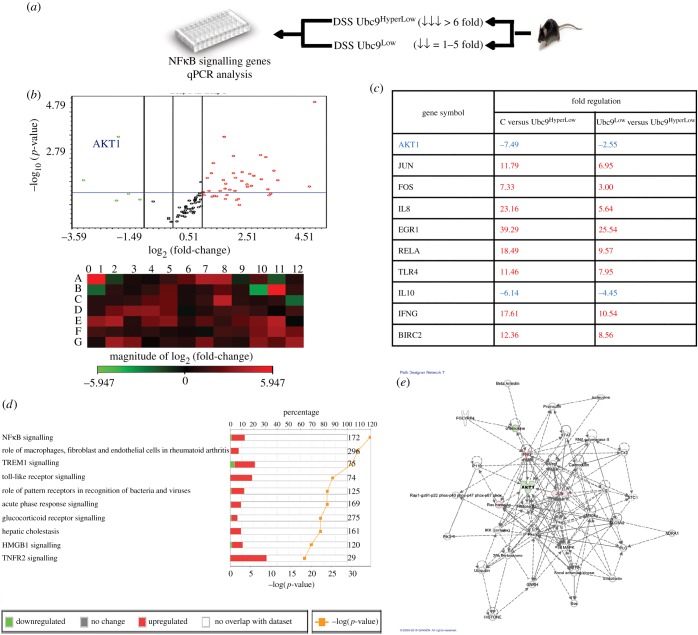
Ubc9 levels correlate with the severity of inflammation in DSS-7 mice. (a) Schematic overview of steps involved in gene expression analysis using qPCR in mice. Total RNA was extracted by colonic tissue of DSS-treated animals with hyperlow Ubc9 and low Ubc9 along with the control group. This RNA was processed for qPCR array and the data plotted as volcano plots (b, top) display significant inflammatory gene activation in DSS animals. In volcano pots, horizontal axis shows fold change (log2) and vertical axis represents the statistically significant dysregulated genes (−log10 scale; p < 0.05, blue line). Heat maps (b, bottom) show pattern of expression of DSS-7-Ubc9HyperLow compared with DSS-7-Ubc9Low. (c) Table showing the fold change of various significant genes altered in DSS-7 mice samples. (d) IPA comparative analysis showing significant signalling altered in DSS-7-Ubc9HyperLow compared with DSS-7-Ubc9Low. (e) Akt1-dependent IPA functional network.